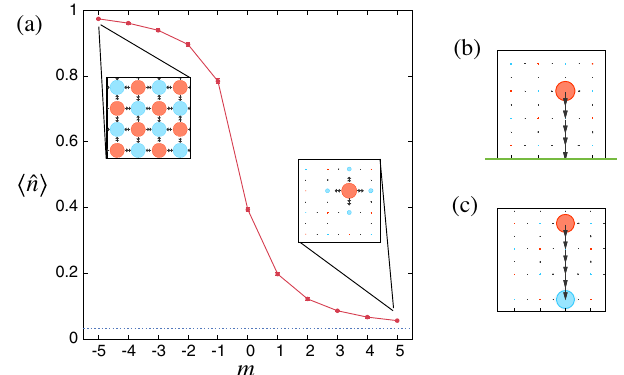
FIG. 12. Occupation for pinned charges in an 8 × 8 system of 1 and a ¼ 1 =t ¼ 1 . the original QED Hamiltonian with g e ¼ (a) Particle density for one charge pinned in the zero-charge 0 with respect to the bare mass m for periodic sector Q tot ¼ boundaries. The system transitions from the completely filled charge-crystal phase to the pinned charge screening. (b) Field plot 1 with open boundaries for a system with total charge Q tot ¼ 0 (green line). (c) Field plot for two pinned charges in the Q tot ¼ symmetry sector. All of the field plots are 4 × 4 subsystems embedded in an 8 × 8 simulation. For panels (b) and (c), the mass term is set to m ¼ 4